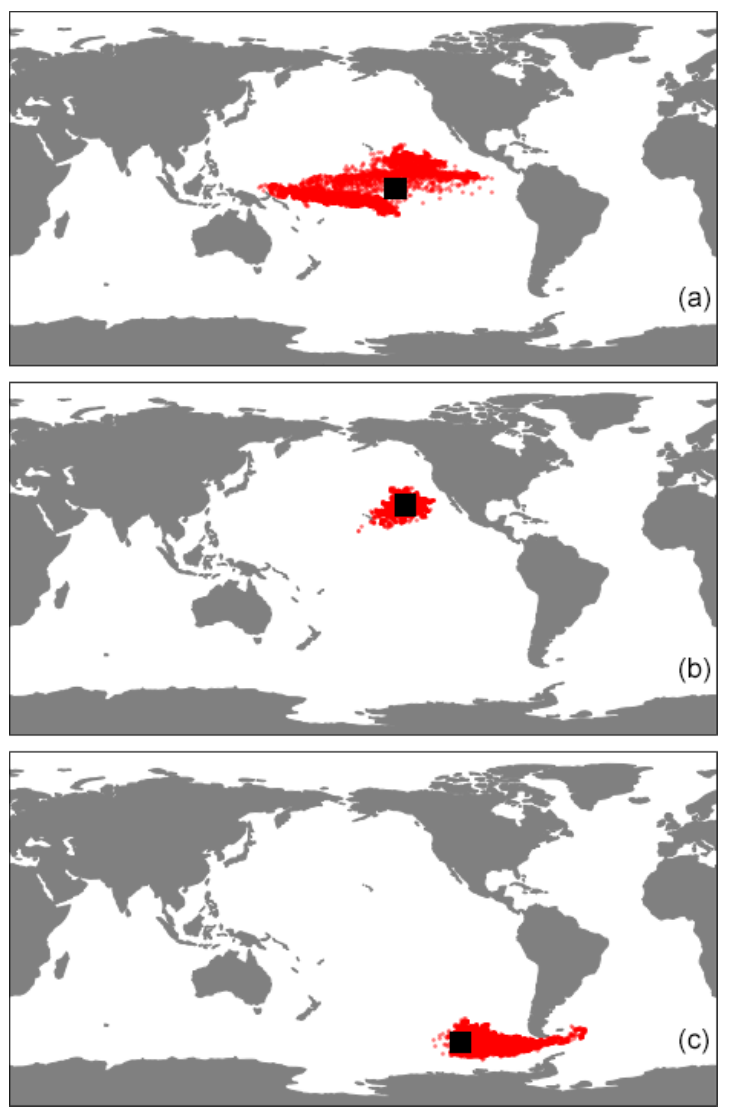
Figure E1. The horizontal trajectories of particles released in the three regions of our study, (a) EqPac, (b) NPSG and (c) SO, when 3D advection is included. The simulations ran for 180d, and the black squares represent the initial release location.